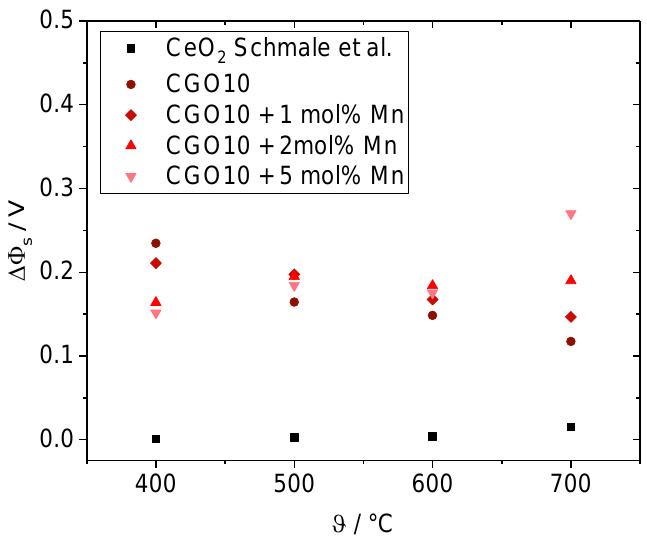
Figure 5. Temperature dependence of the space charge potential of Ce 0.9− x Gd 0.1 MnxO 2−δ in comparison to nominally pure ceria (99.9% purity) [23] calculated by Equation (2).